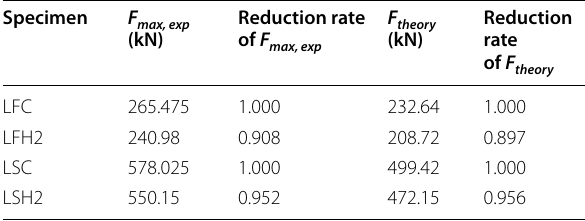
Table 5 Comparison of experimental and theoretical values of maximum lateral